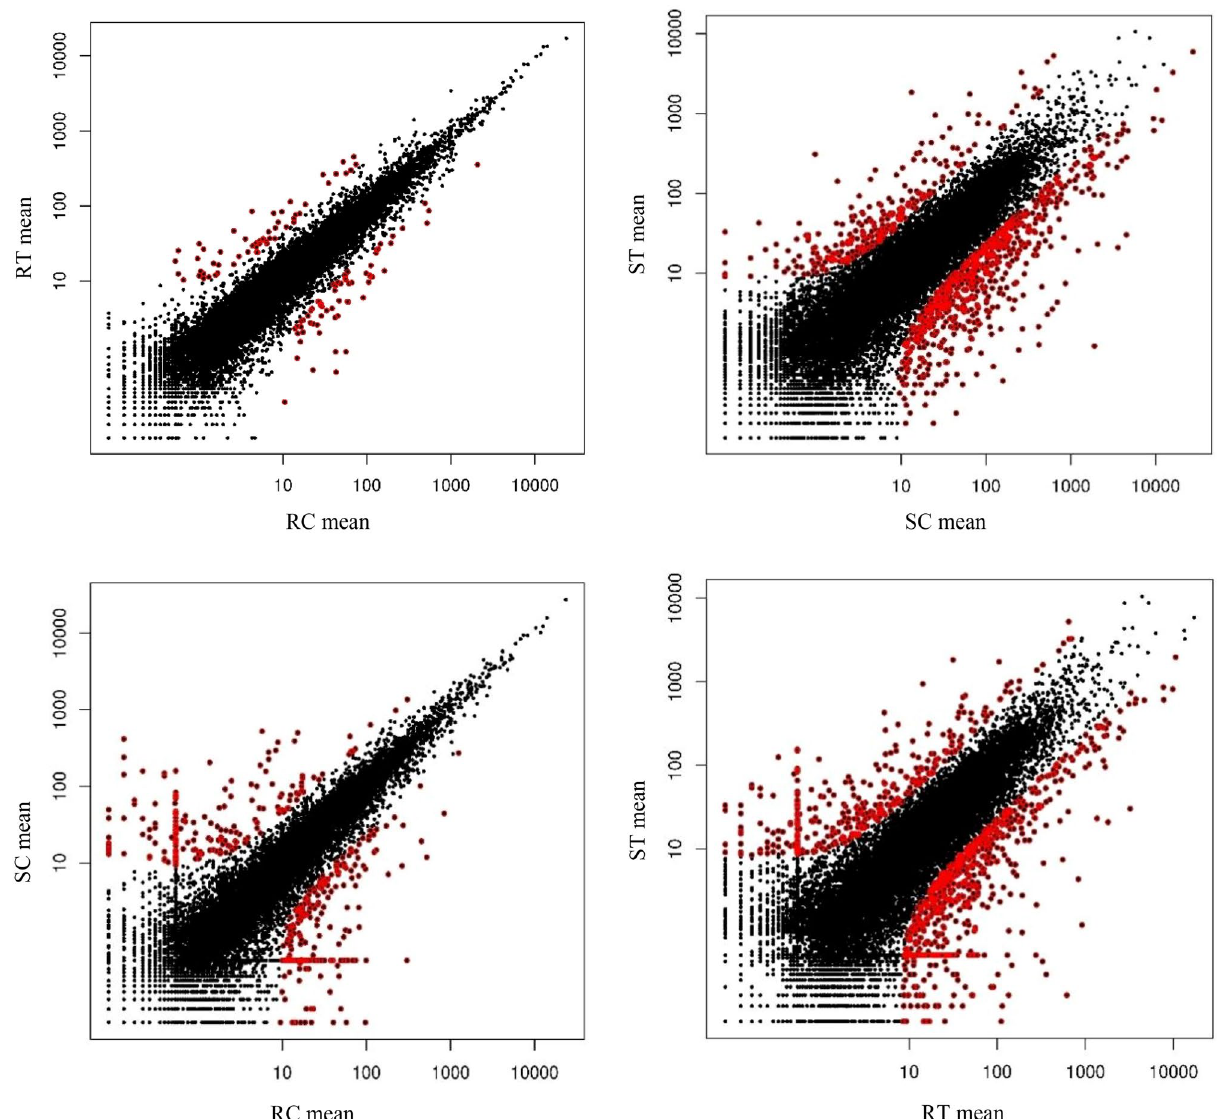
Figure 4. Gene expression scatter plots summarize the expression values for the susceptible and resistant accessions of Ae. tauschii under rust inoculation or mock inoculation. The P. triticina pathotype CDHLQ was used to inoculate genotypes while the inoculum for mock-inoculated plants included only talcum powder. Expressed genes for both conditions are highlighted in black while differentially expressed genes are shown in red. NOISeq simulated five technical replications for any of the experimental conditions and therefore, X and Y axes represent the average expression values of each condition. RC (resistant control), RT (resistant treatment), SC (susceptible control), and ST (susceptible treatment). The scatter plots were created using the ‘NOISeq’ R/ Bioconductor package 20